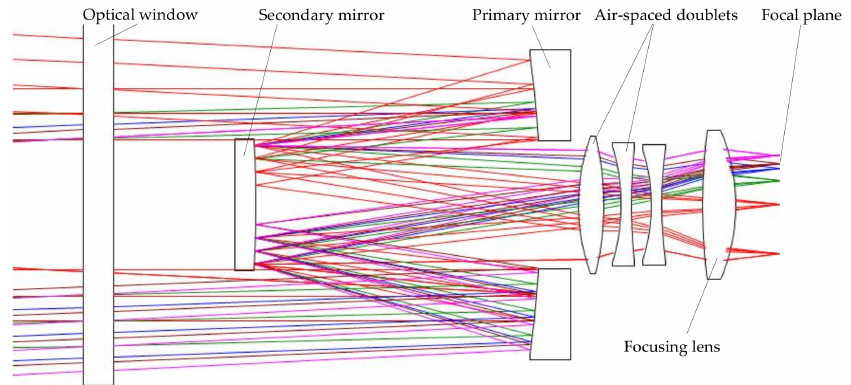
Figure 3. Schematic of the optical system for the oblique airborne-mapping